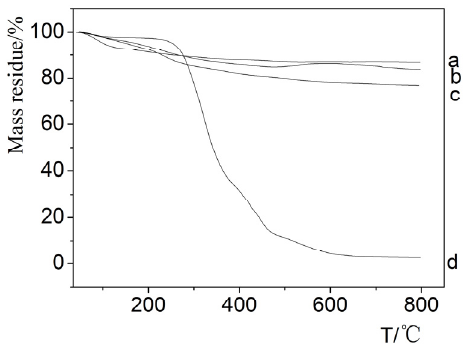
Figure 5. TGA curves of PVA/SiO 2 -TiO 2 hybrids. ( a ) SiO 2 -TiO 2 gel fiber; ( b ) PVA/SiO 2 -TiO 2 hybrid fiber (w(SiO 2 :TiO 2 )% = 85); ( c ) PVA/SiO 2 -TiO 2 hybrid fiber (w(SiO 2 :TiO 2 )% = 70); ( d ) PVA